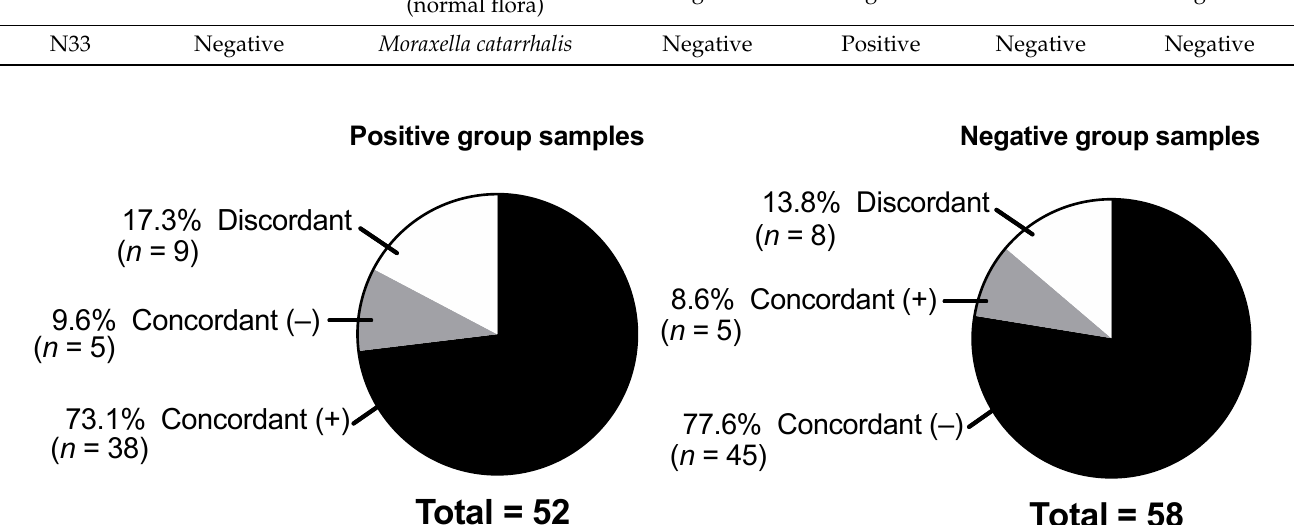
Figure 2. Agreement of results between the four Streptococcus pneumoniae urine antigen tests.